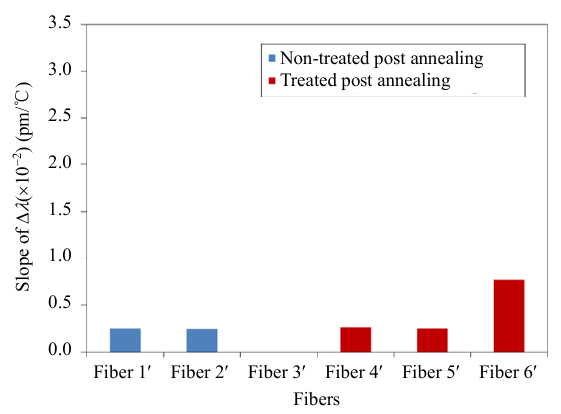
Fig. 7 Slope value Δ  of wavelength difference between  a and  b for treated and non-treated fibers during post annealing process (durability